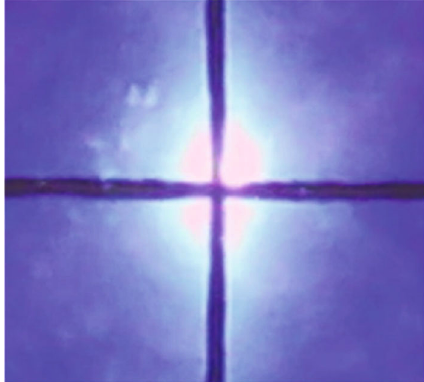
Figure 13: A sample of solar image captured by CCD camera with blue colour background.